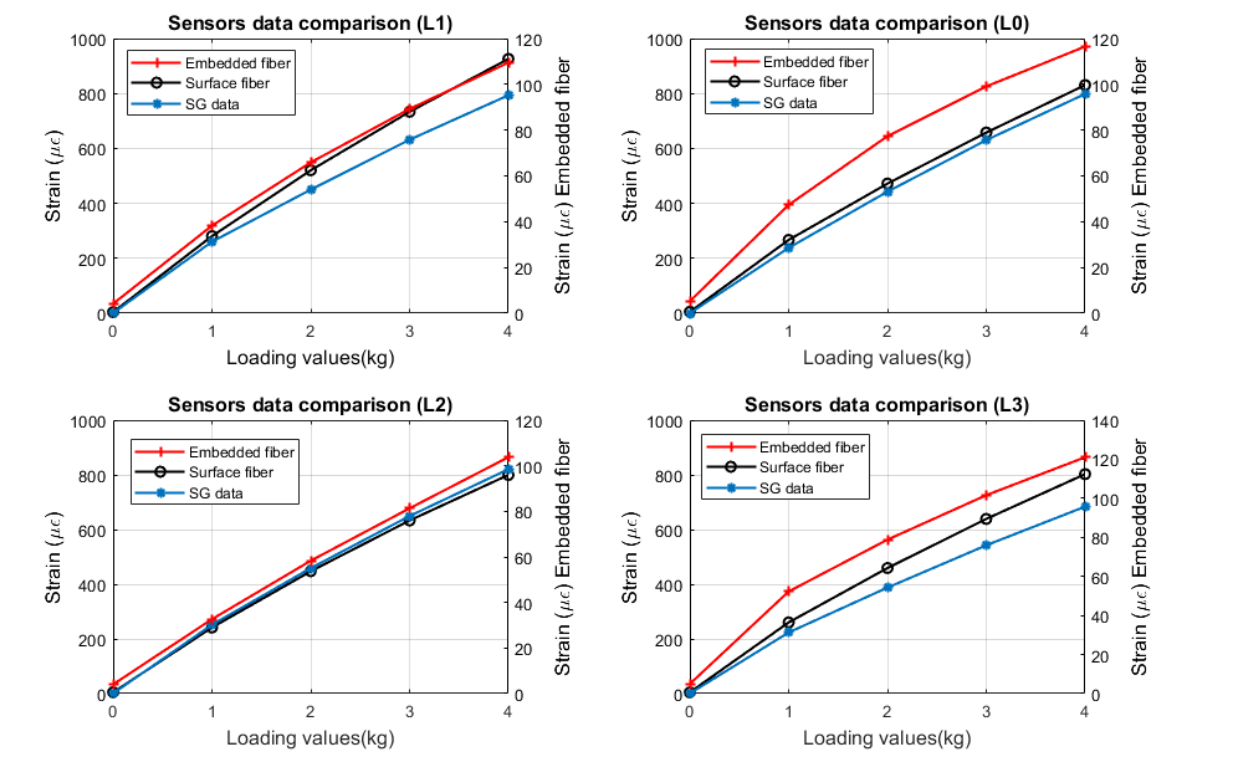
Figure 4. Dataset comparison for different types of